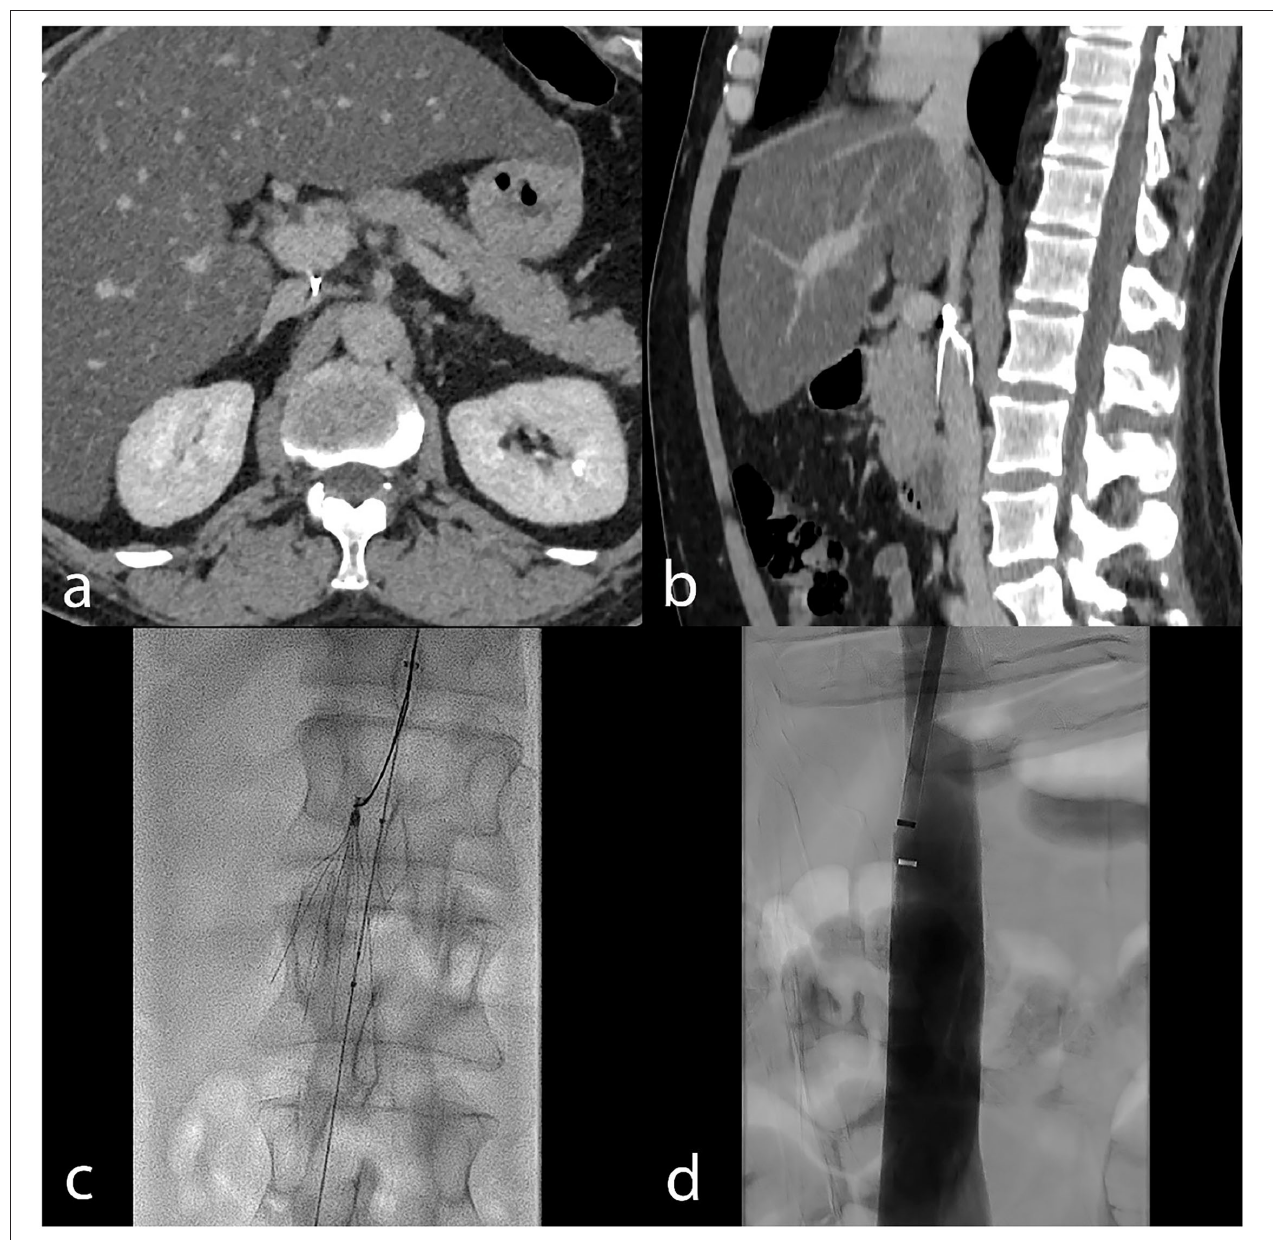
FIGURE 3 | Embedded hook in the IVC wall is a common technical failure reason. CT venography in a patient with an embedded hook is shown on axial (a) and sagittal (b) images. In this case, advanced retrieval with the balloon displacement technique (periprocedural fluoroscopy image, (c) allowed removal. Final transcatheter subtracted cavography (d) shows the absence of